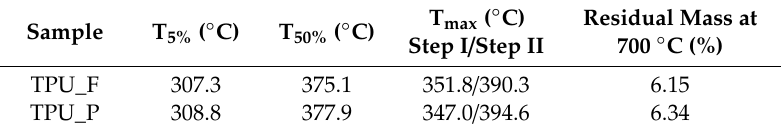
Table 2. Thermal decomposition characteristics of the TPU filament and